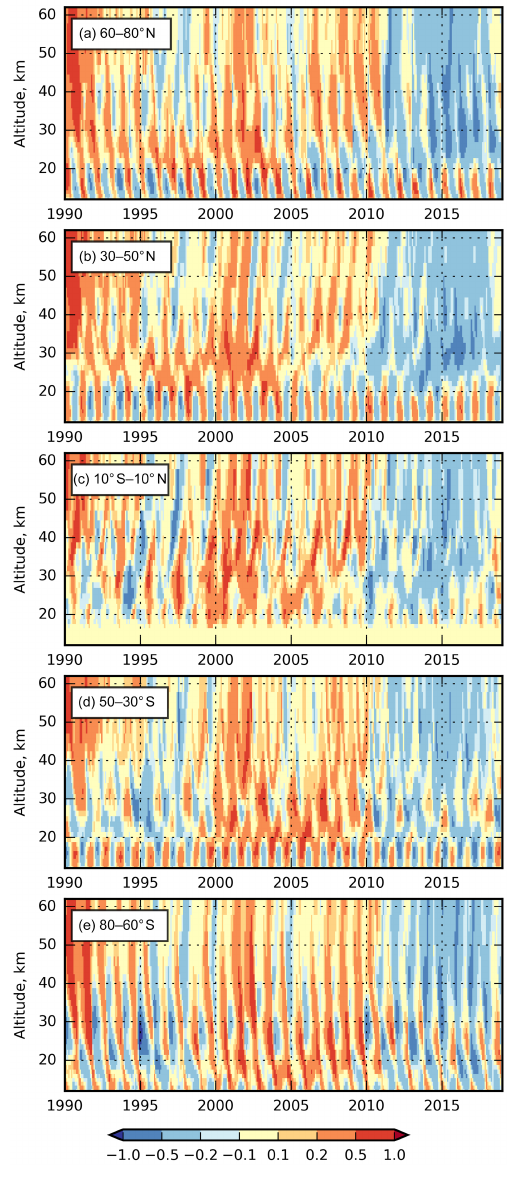
Figure 13. Anomaly of the ideal-age AoA (years) for the period of 1990–2018 with respect to the mean